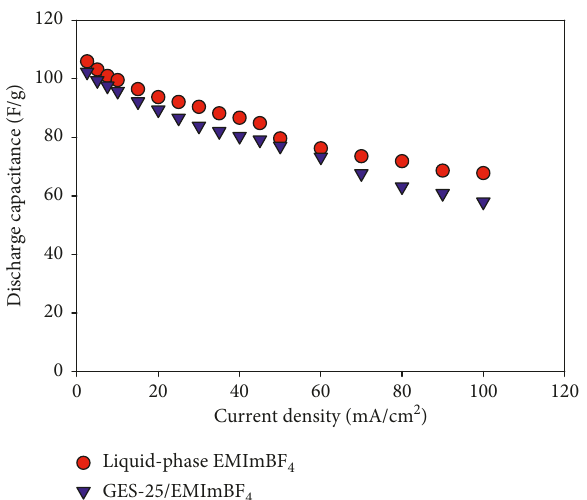
Figure 6: Charge-discharge curves of the EDLC test cells with liquid-phase EMImBF current densities of (a) 50 and (b) 100mA/cm 2 .